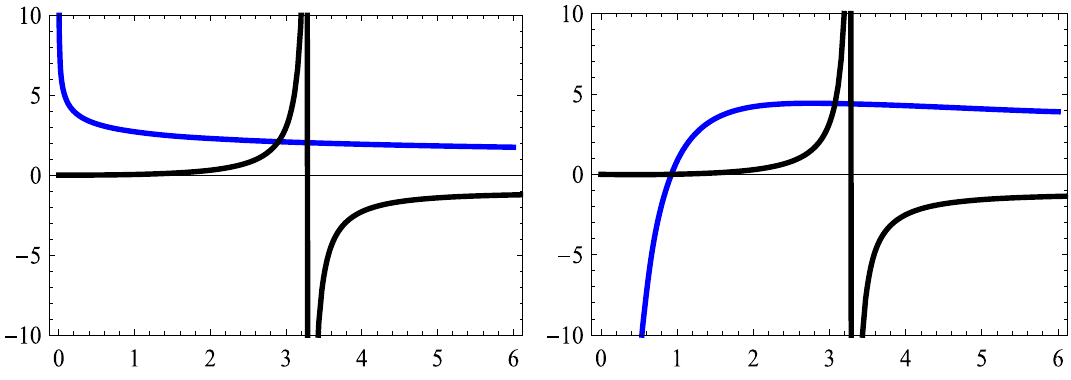
, b = 1 , (cid:20) = 1 , r = 1 , m = 8 , (cid:18) = − 1 , q = 1. Left: α = 2 and a = 0 3